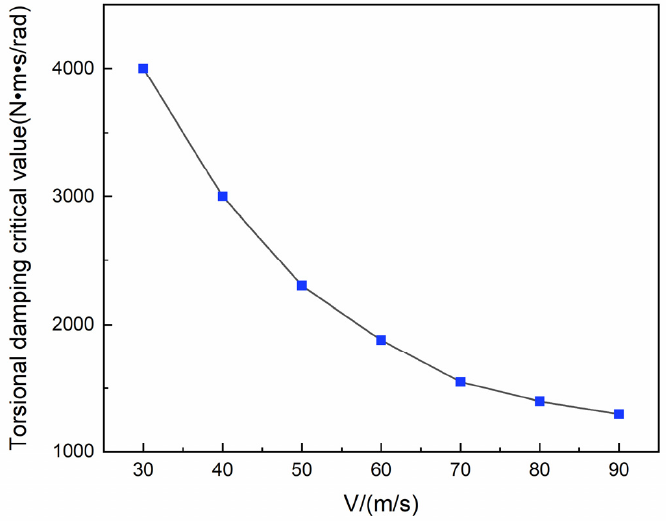
Figure 12. Critical value C d of torsional damping at different taxiing speeds.